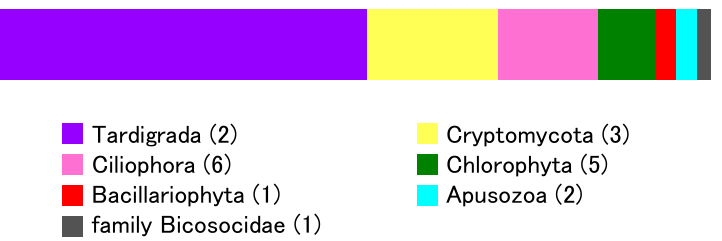
Figure 4. Community structure of eukaryal clones at the phyla level. The number in parenthesis is the number of OTUs belonging to each phylum. The family Bicosocidae has no phylum Table 3. List of eukaryotic clones.